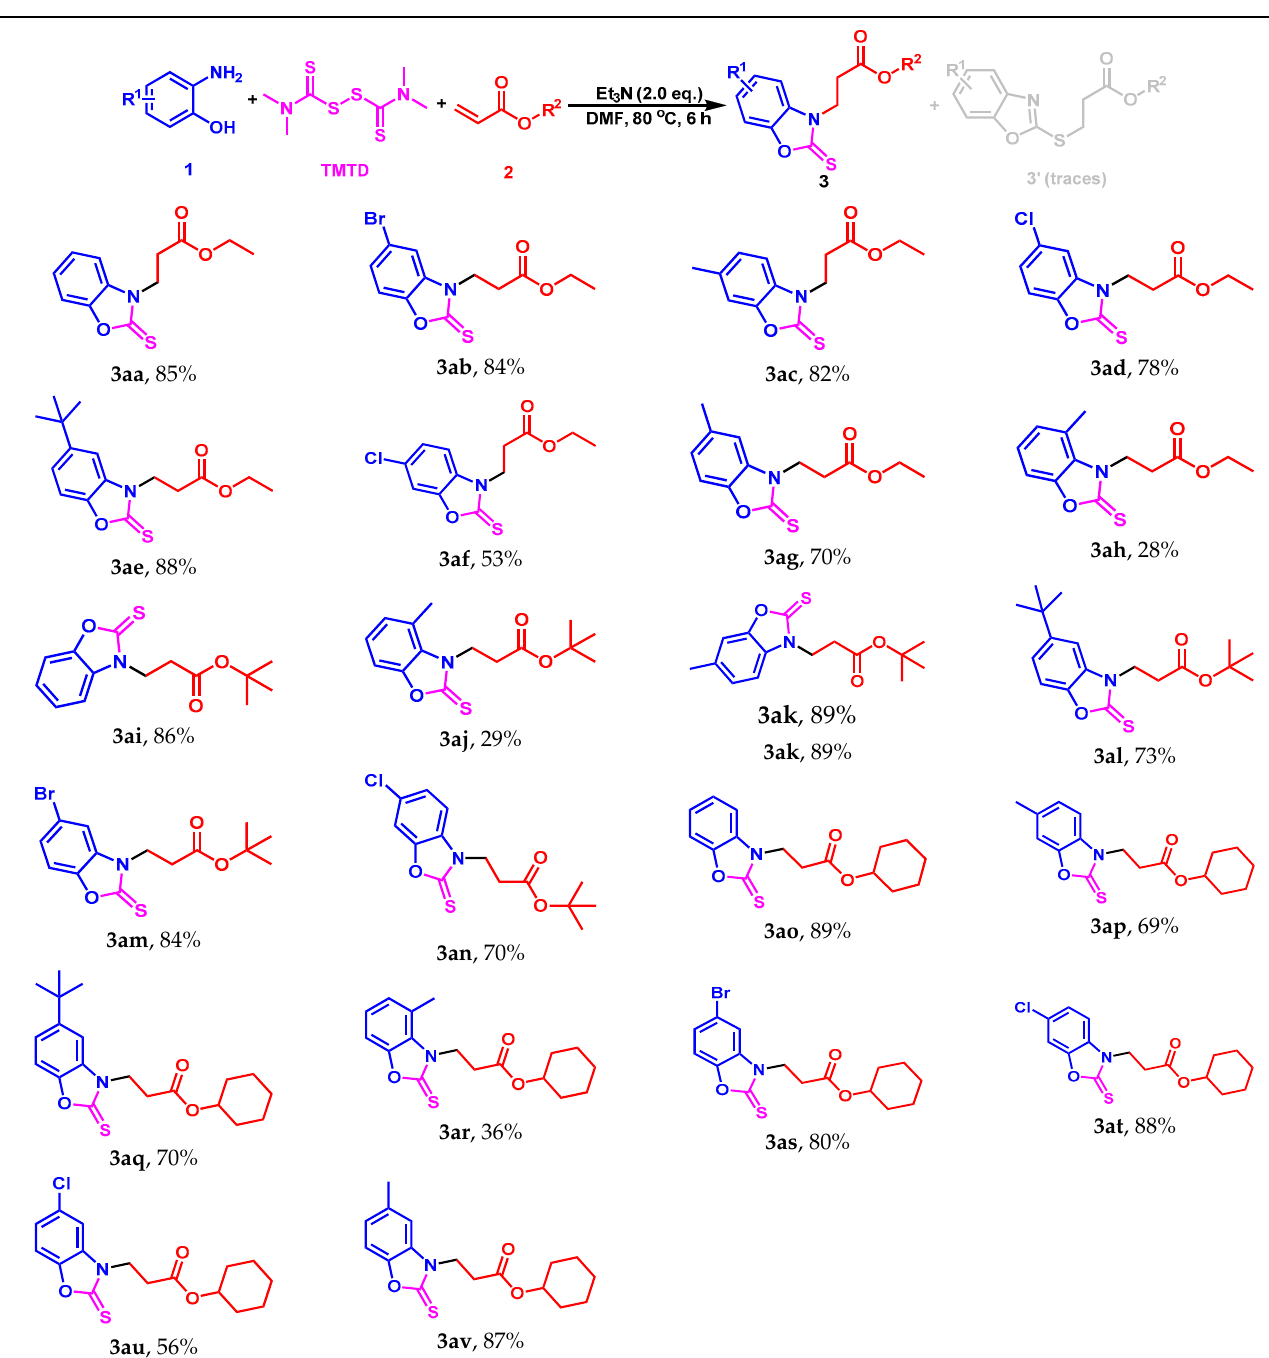
Table 2. One-pot synthesis of benzoxazole-substituted ester compounds a,b .